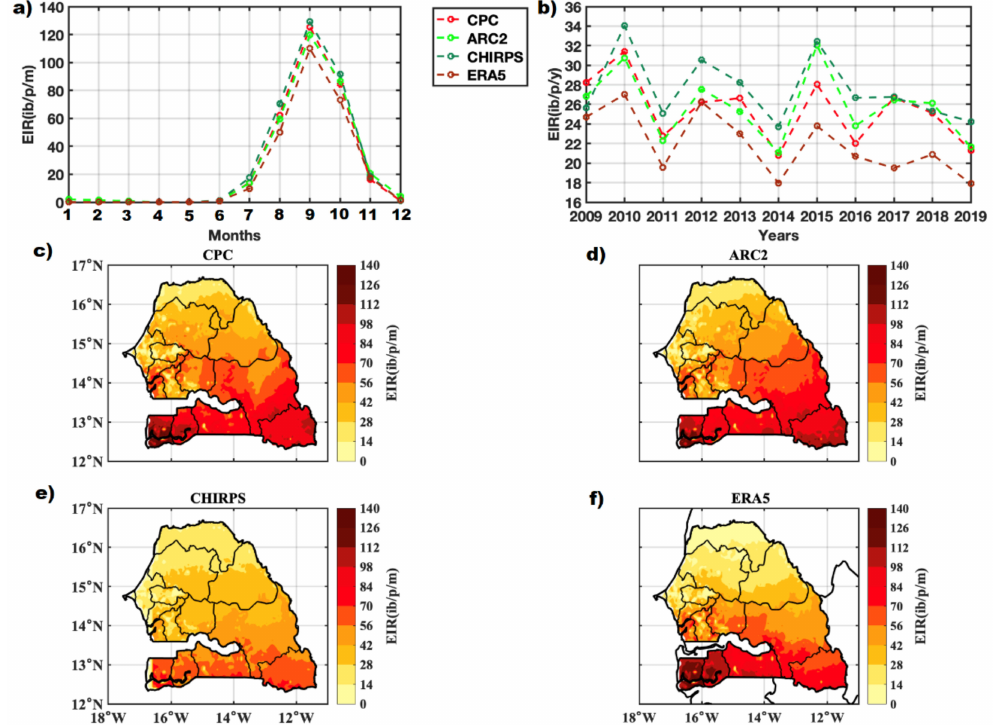
Figure 6. Spatio-temporal variability of the EIR (entomological inoculation rate) in Senegal for the period 2009–2019: annual cycle ( a ), interannual variability ( b ), and spatial distribution for CPC ( c ), ARC2 ( d ), CHIRPS ( e ), and ERA5 ( f